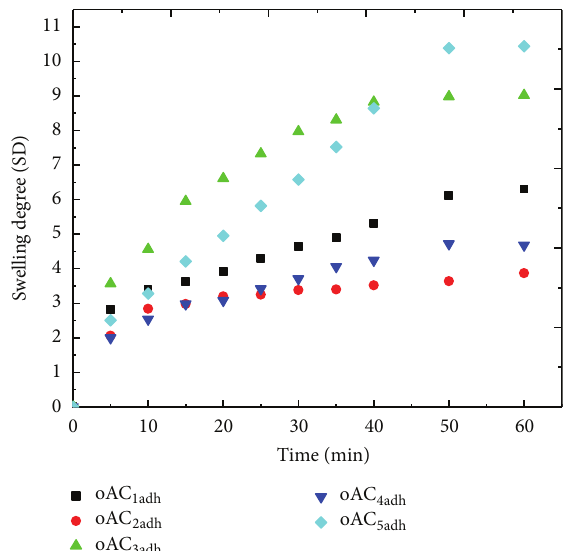
Figure 4: Swelling degree of oxidized alginate/k-carrageenan hydrogels oAC 1adh –oAC 5adh .